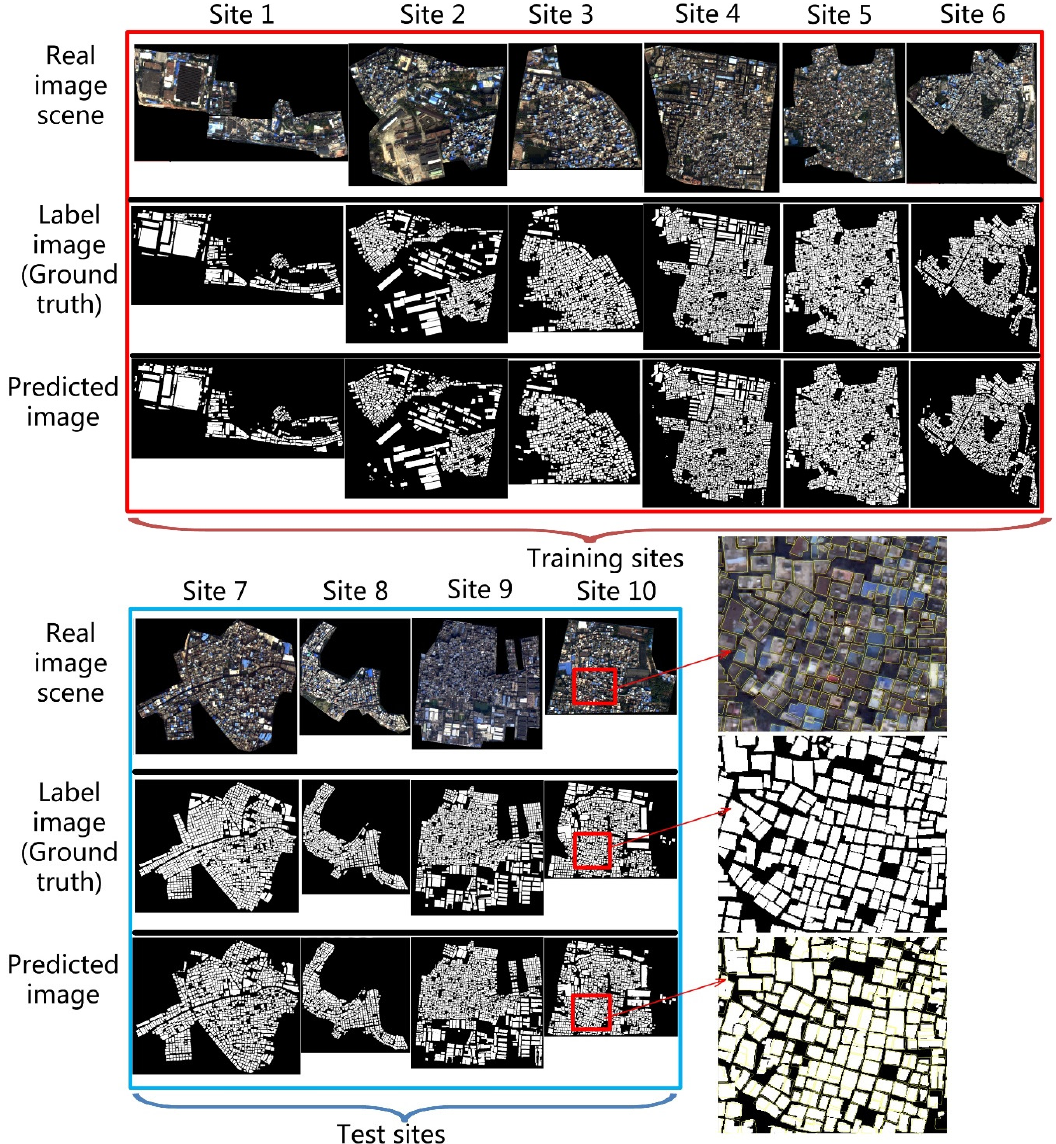
Figure 5. Performance of building segmentation by U-net.